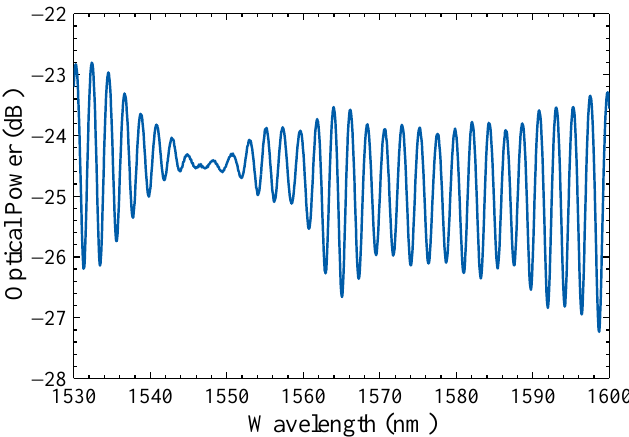
Figure 4. Reflection spectrum of the developed sensor.